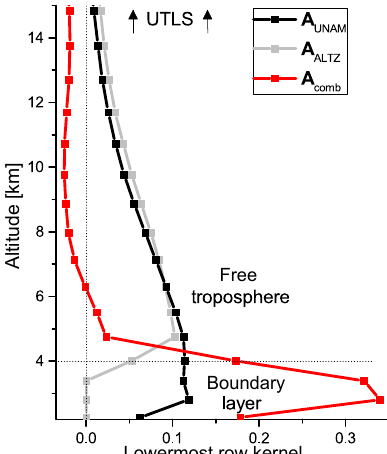
Figure 10. O 3 row kernels for the lowermost altitude of different FTIR products. Black: 2.3km row kernel for the UNAM product; grey: 4km row kernel for the Altzomoni product; red: 2.3km row kernel for the combined